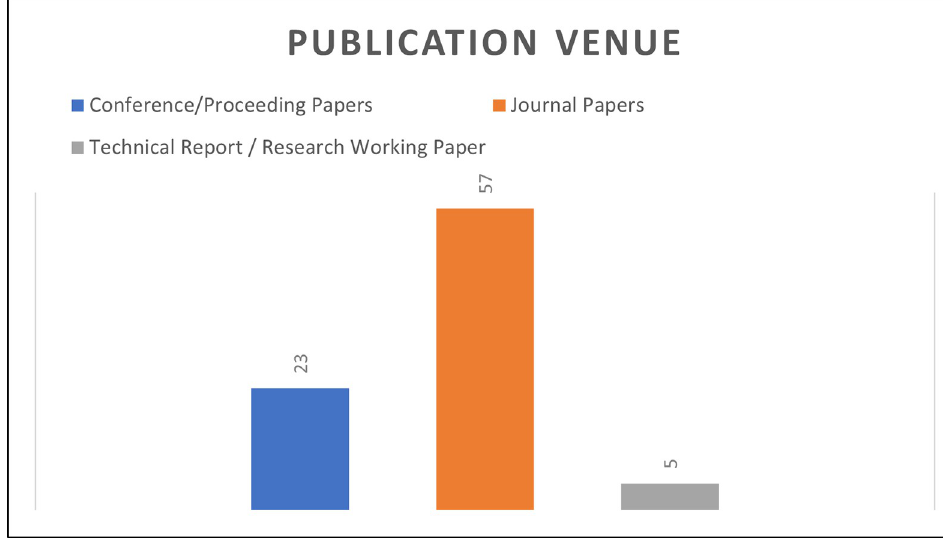
Fig 4. Analysis based on publication